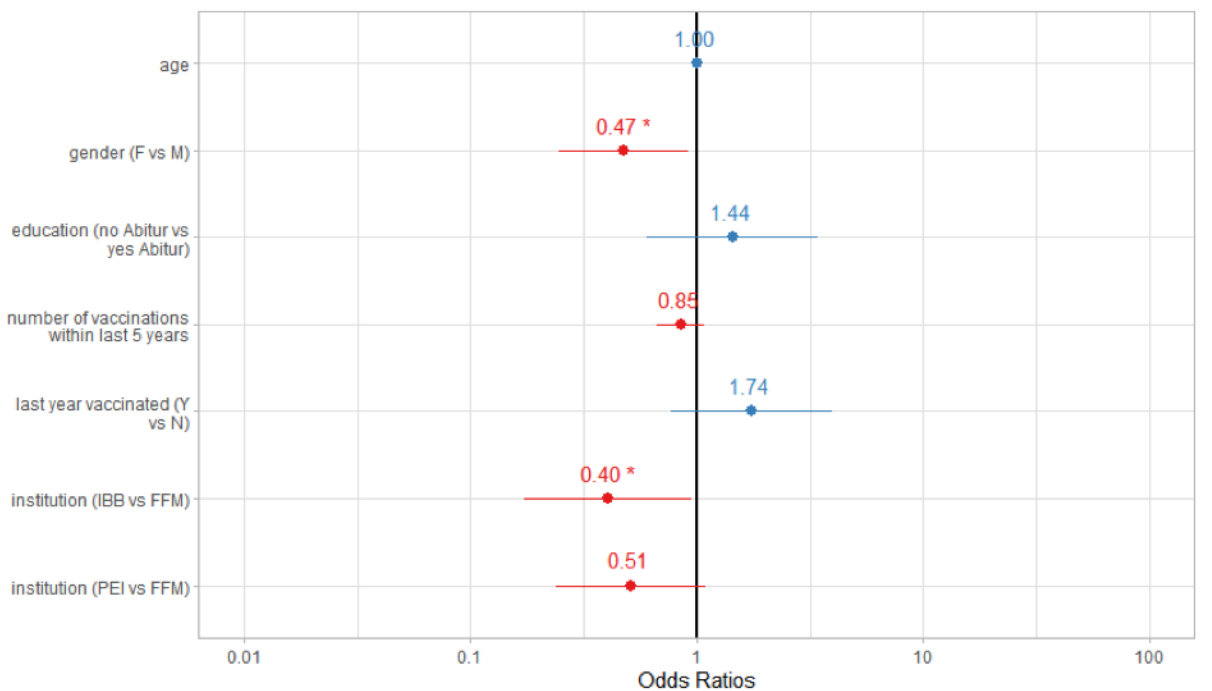
Figure 4. Factors associated with fully adherent app use versus partially adherent app use over 3 months, pseudoR2 (McFadden) = 0.065. F: female; M; male; Y: yes; N: no; IBB: Investitionsbank Berlin; FFM: University Hospital Frankfurt; PEI: Paul Ehrlich Institute.